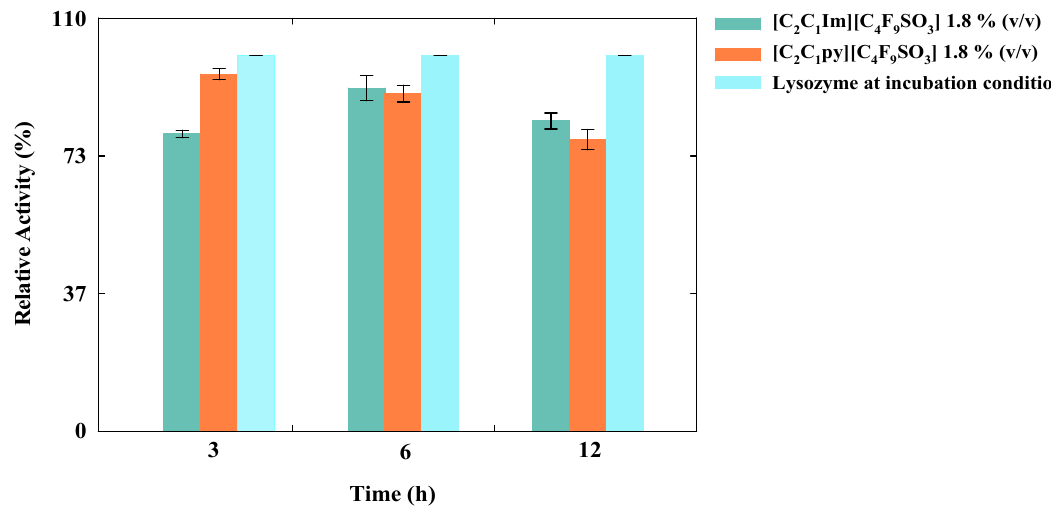
Figure 4. Relative activity of the encapsulated lysozyme (0.2 mg / mL) in [C 2 C 1 Im][C 4 F 9 SO 3 ] and [C 2 C 1 py][C 4 F 9 SO 3 ] after 3, 6, and 12 h after incubation at 4 °C during 24 h.